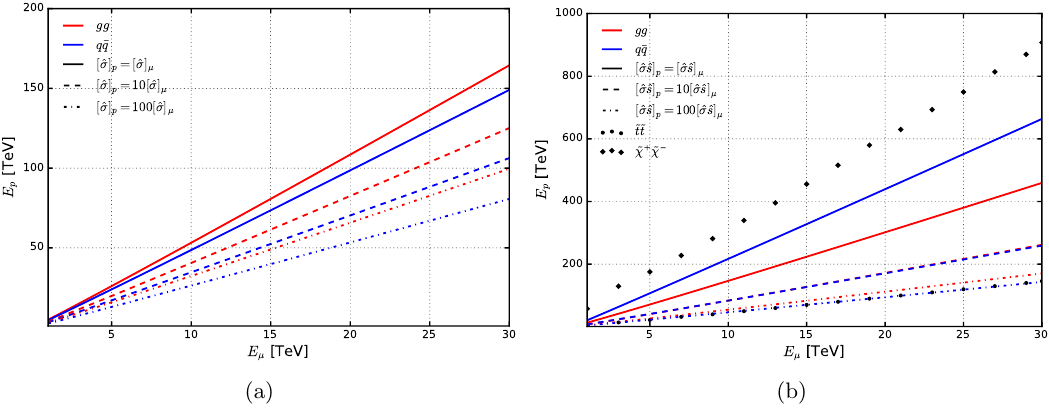
p s p [TeV] required to reach the same beam-level p s (cid:22) [TeV] for (a) 2 ! 1 and (b) 2 ! 2 parton-level